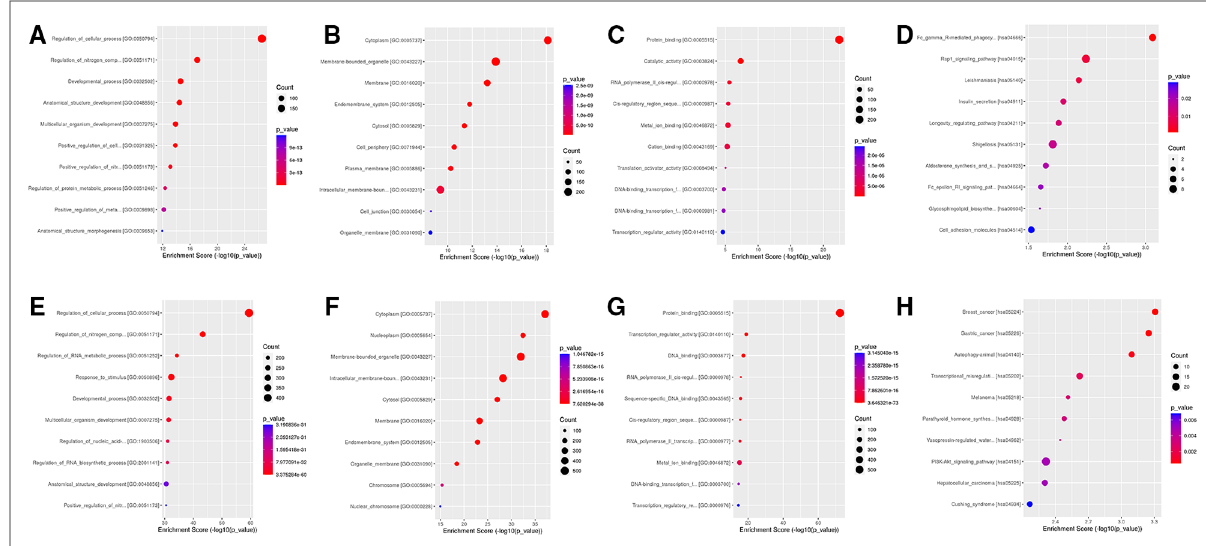
FIGURE 4 Go and KEGG analysis for target genes of DEmiRNAs. ( A ) BP group for upregulated DEmiRNAs. ( B ) CC group for upregulated DEmiRNAs. ( C ) MF group for upregulated DEmiRNAs. ( D ) KEGG for upregulated DEmiRNAs. ( E ) BP group downregulated DEmiRNAs. ( F ) CC group for downregulated DEmiRNAs. ( G ) MF group for downregulated DEmiRNAs. ( H ) KEGG for downregulated